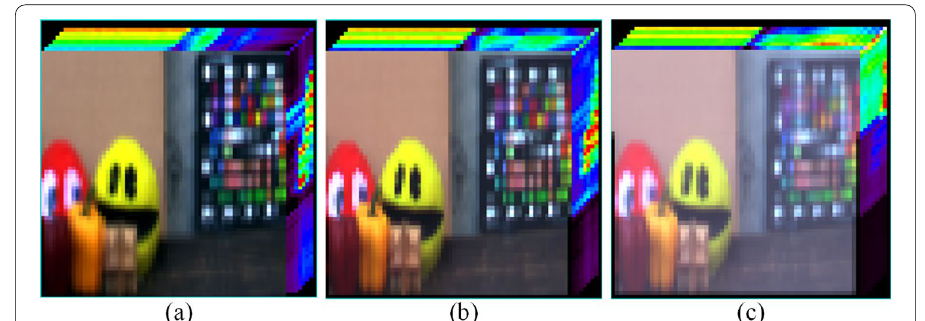
Fig. 12 The reconstructed datacube for depth estimation simulation